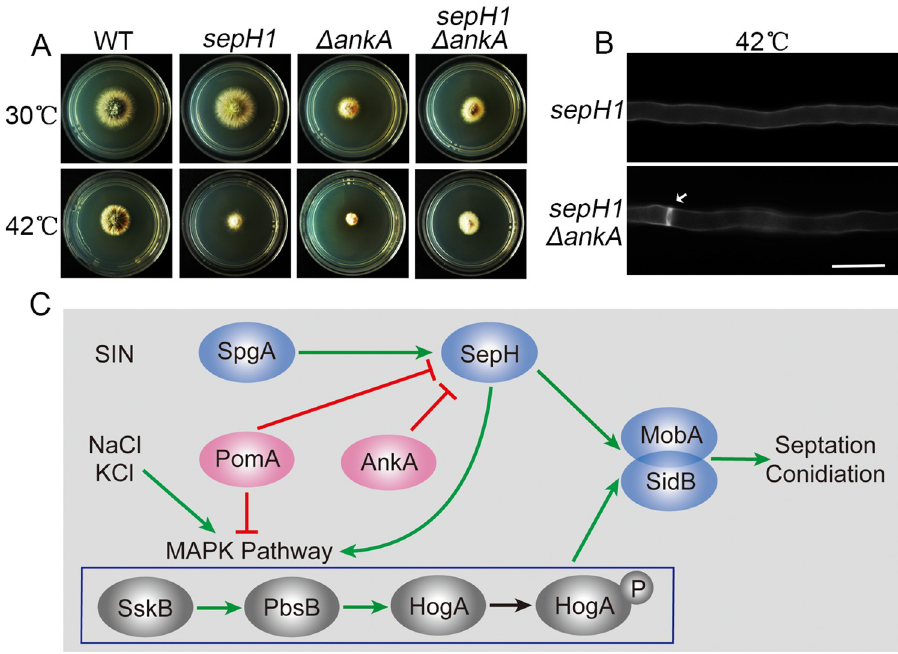
Fig 6. Suppressed sepH1 defects by deletion AnkA in septation and a cross-link working model between the SIN and the MAPK. (A) Colony morphologies of the wild type (TN02A7), sepH1 , Δ ankA sepH1 and Δ ankA strains cultured on YUU at 30 or 42 ˚C for 2 days. (B) Septa comparison in hyphal cells stained with CFW in the indicated strains cultured in liquid rich media YUU at 42 ˚C for 20 h. Arrows indicate the locations of septa. Bars, 10 μ m. (C) A schematic model for the MAPK and the SIN-SepH-MobA/SidB pathways regulated by PomA-AnkA regulation during septation and conidiation. Green arrows indicate induce and labels for red lines indicate inhibit.